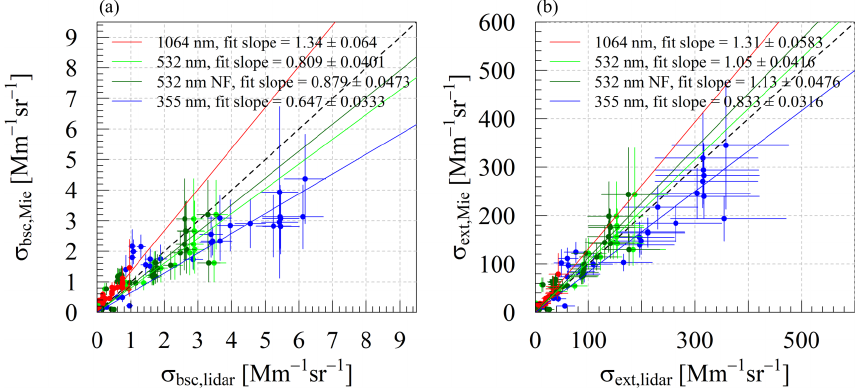
Figure 4. Scatterplots of the measured (lidar) and modeled (Mie) ambient state aerosol particle light backscattering ( σ bsc (λ) ; panel a ) and extinction ( σ ext (λ) ; panel b ) coefficient derived during flight 20150626a. Vertical uncertainty bars indicate the range within ± 3 times the standard deviation of the mean. Horizontal uncertainty bars denote the uncertainty of the lidar estimates. Colored lines represent linear fit at the corresponding color for 1064nm (red), 532nm (green; NF – dark green), and 355nm (blue). The black dashed line represents the 1 : 1 line.